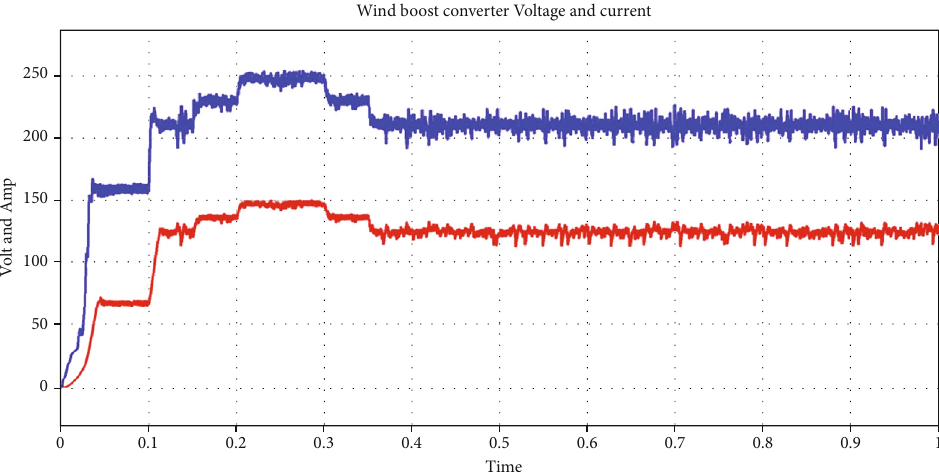
Figure 19: Simulation results for DNN-wind MPPT converter voltage and current (for di ff erent wind speeds).